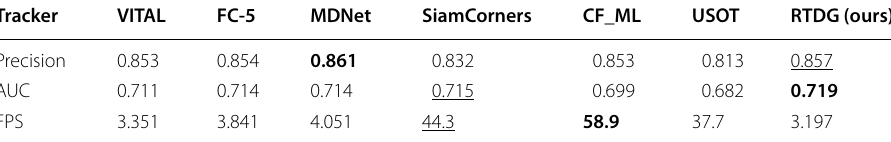
Table 1 Comparison of the state‑of‑the‑art trackers in terms of precision, AUC, and FPS on OTB dataset